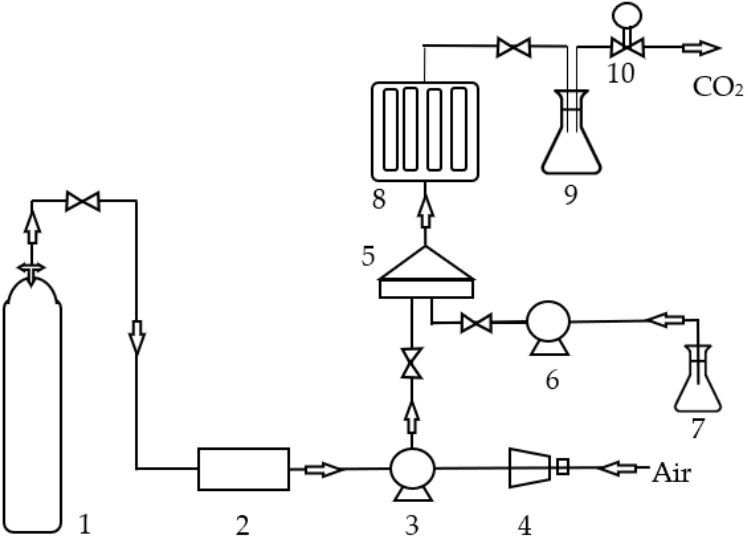
Figure 3. Schematic view of SC-CO 2 extraction unit. CO 2 cylinder (1); CO 2 cooler (2); booster (CO 2 pump-3 and compressor-4); mixer (5); co-solvent pump (6); co-solvent source (7); extraction unit (8); separation vessel (9); flow meter (10).